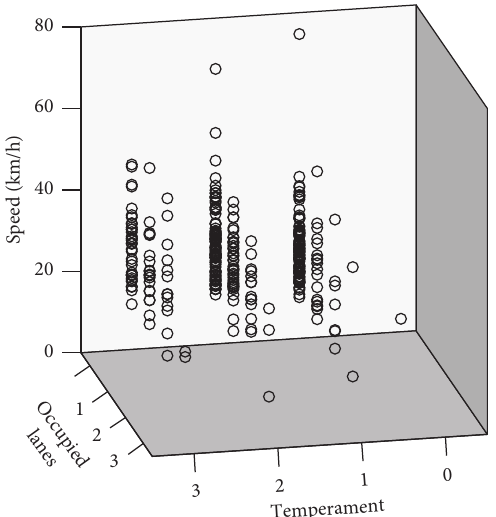
Figure 9: Relationship between driving age, traveling speed, and illegal lane occupation behavior.